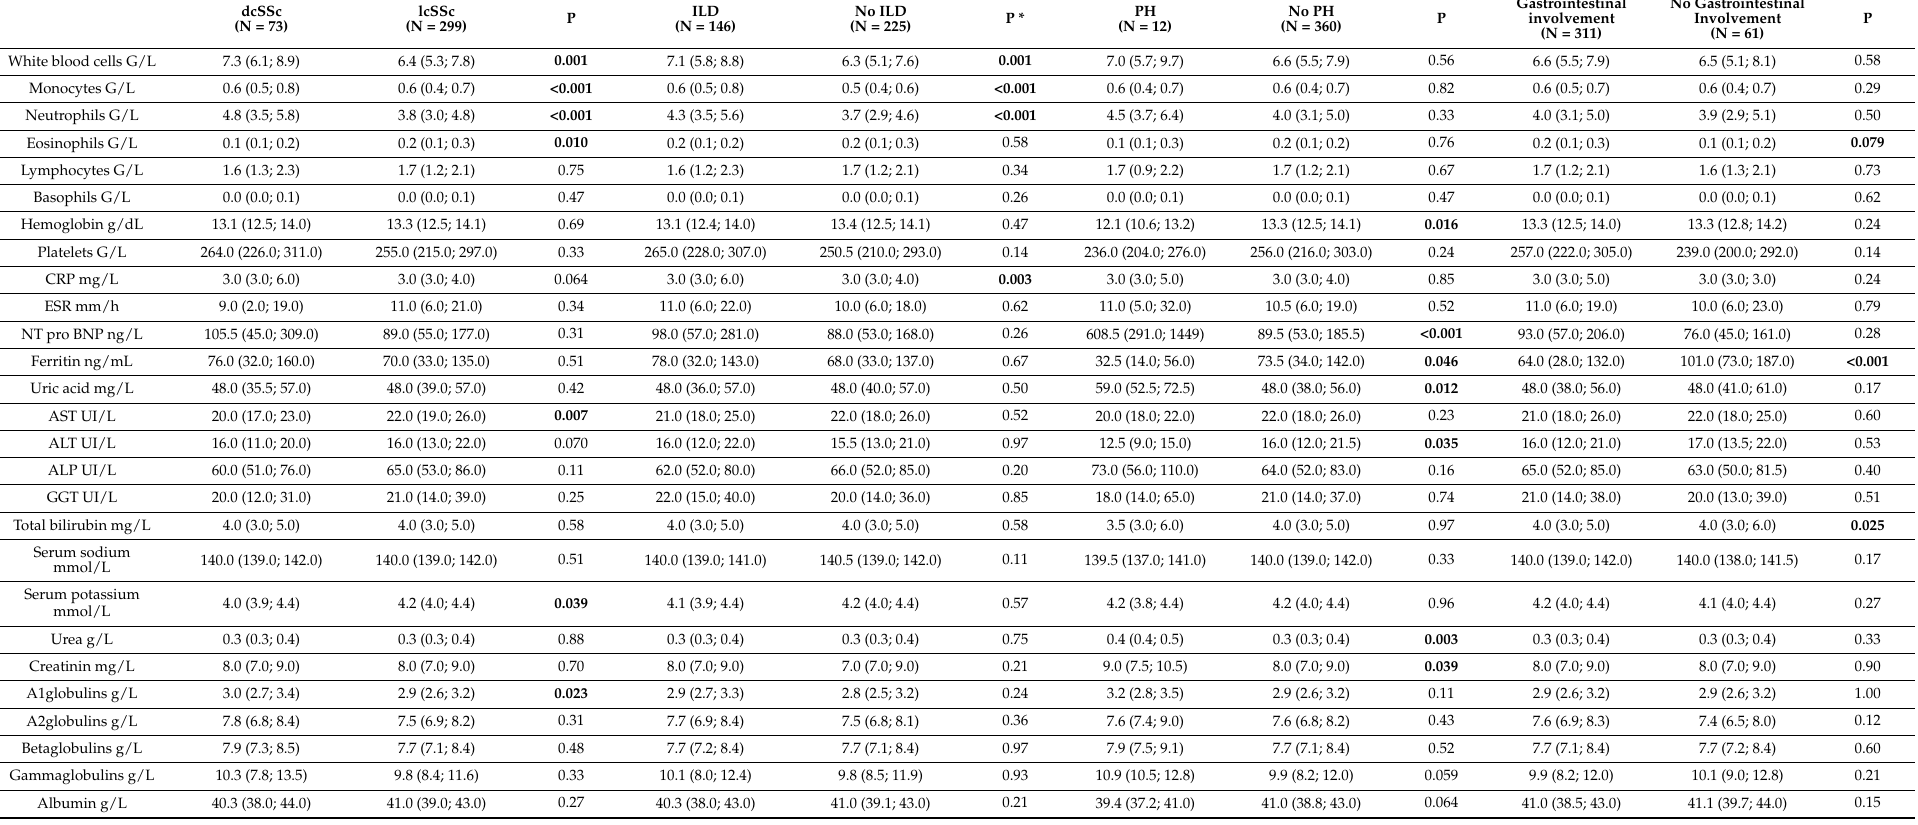
Table 2. Routine laboratory parameters as biomarkers of severity in systemic